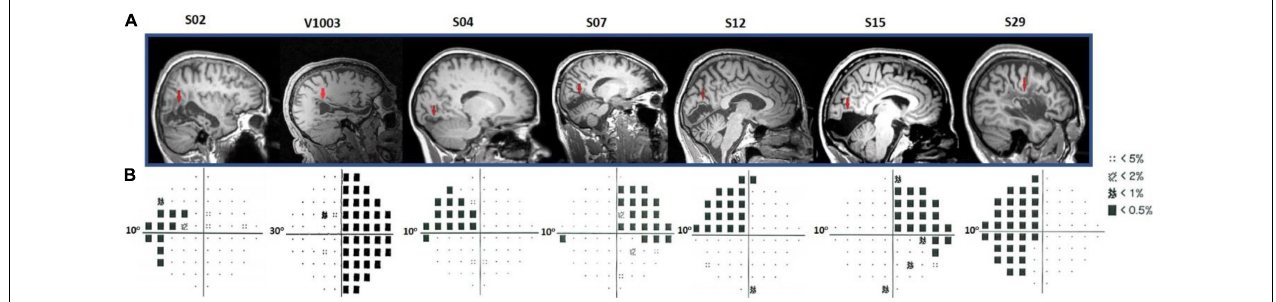
FIGURE 2 | Humphrey’s visual field perimetry test and lesions’ location. (A) Sagittal anatomical planes of patients’ brains. The red arrows point to the location of individual’s anatomical lesions. (B) Subjects S02, S04, S07, S12, S15, and S29 underwent a 10-degree (10-2) and V1003, a 30-degree (30-2) Humphrey’s perimetry test. The black squares in the pattern deviation probability plots correspond to p < − 20 dB. Dotted squares correspond to < − 10 dB of visual sensitivity. The rest of the locations (small black dots) indicate the non-affected (normal) visual